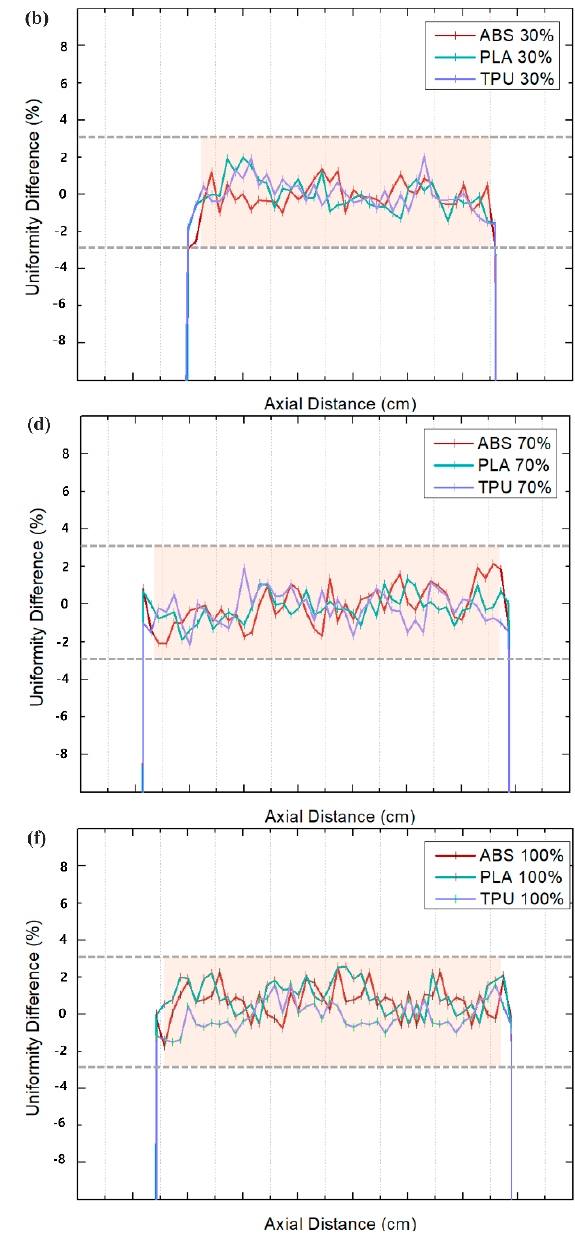
Figure 6. Comparison of uniformity of 3D printing materials (ABS, PLA, TPU) for ( a ) infill density 10%, ( b ) infill density 30%, ( c ) infill density 50%, ( d ) infill density 70%, ( e ) infill density 90%, ( f ) infill density 100%.